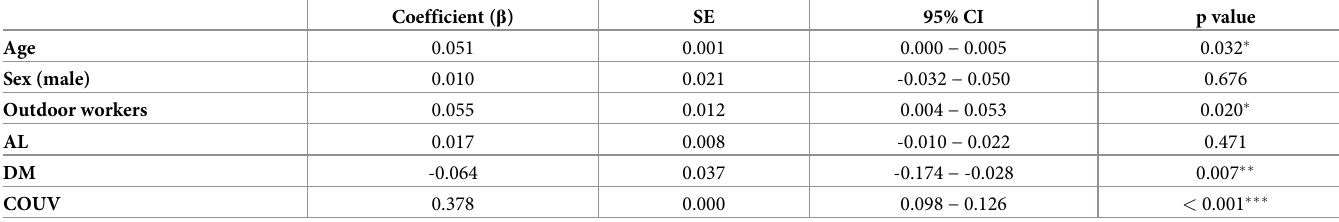
Table 5. Multiple regression analysis on